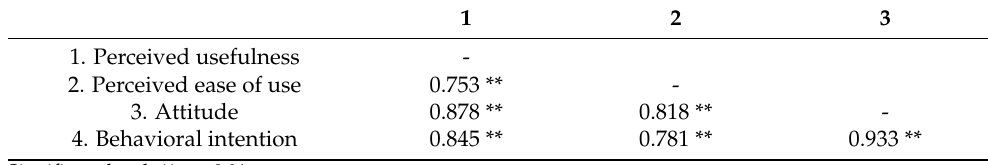
Table 12. Correlation matrix for each dimension.